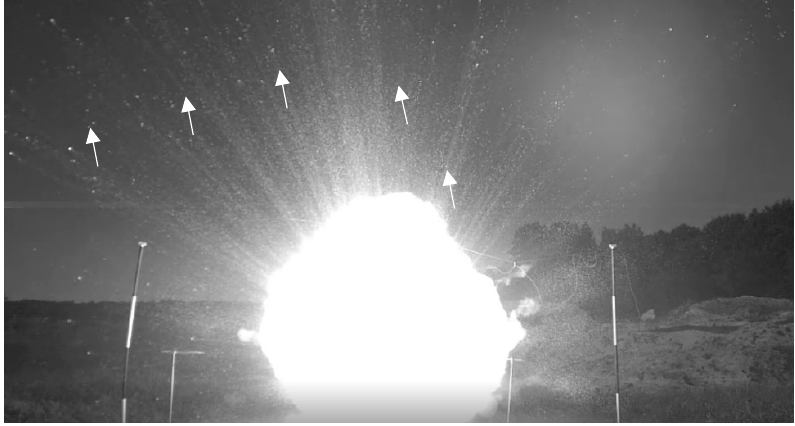
Figure 5. Image of the 500 g test (Test 7), in which burning Al particles (white arrows) were expelled.